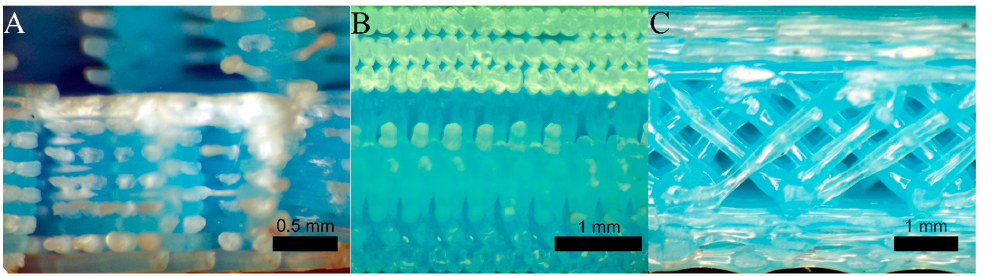
Figure 14. Breaking section, specimens with orientation in the ( A ) X-, ( B ) Y-, and ( C ) Z-direction.